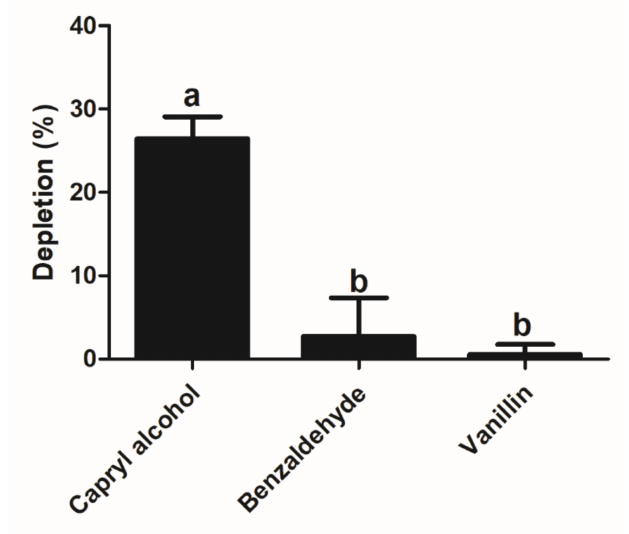
Figure 5. The degradation abilities of recombinant SzeaGSTd1 for capryl alcohol, benzaldehyde, and vanillin. Error bars represent mean ± S.D. of three independent experiments conducted in three replicates. Different letters on the error bars indicate significant differences identified by ANOVA and HSD tests ( p <